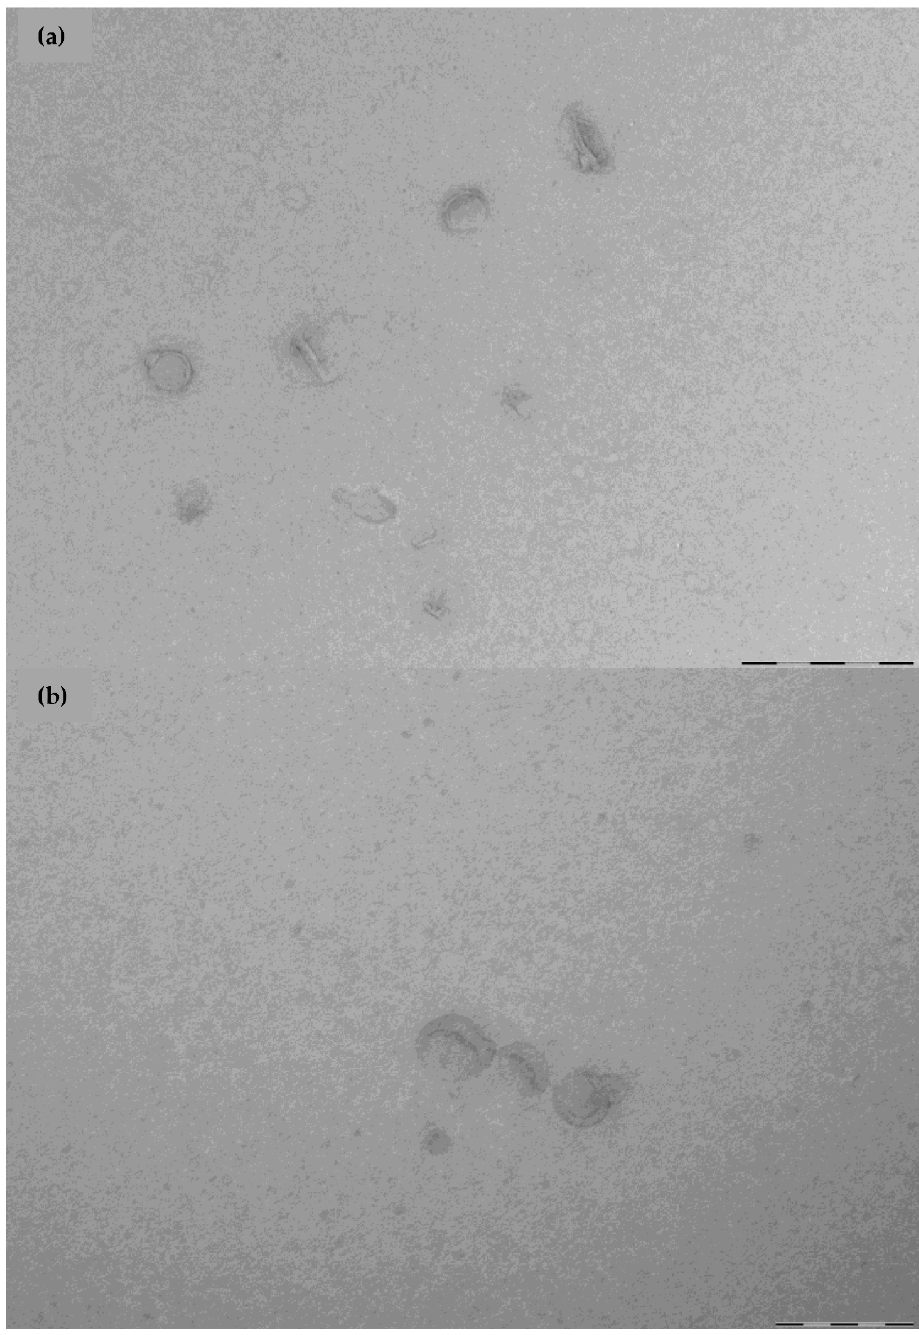
Figure 5. TEM images of the liposomes. ( a ) Liposome L α -PC (L- α -phosphatidylcholine), and ( b ) POPE:POPG (1-palmitoyl-2-oleoyl-phosphatidylethanolamine: 1-Palmitoyl-2-oleoyl-sn-glycerol-3-phosphoglycerol (3:1, mol/mol). The scale bar stands for 200 nm.